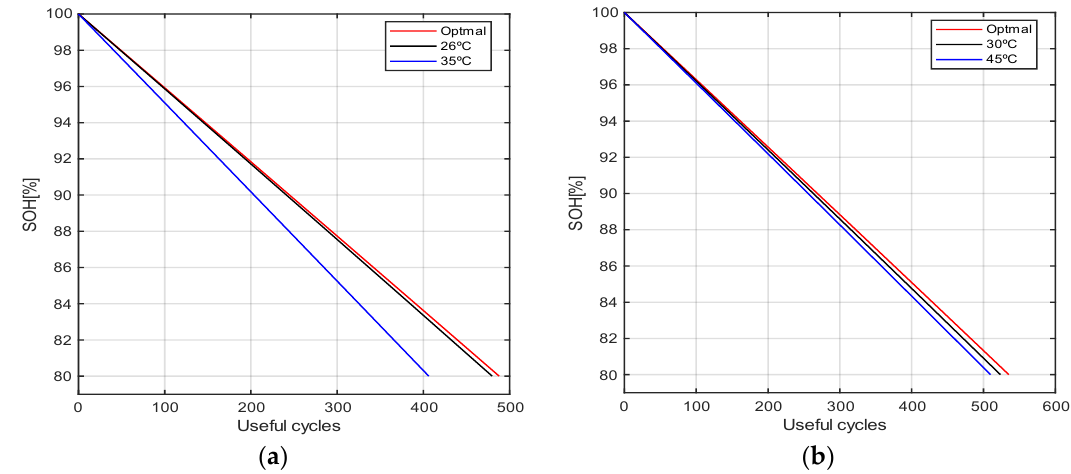
Figure 11. Simulation results for NCA cell at 1C ( a ) and 2C ( b ) discharge.